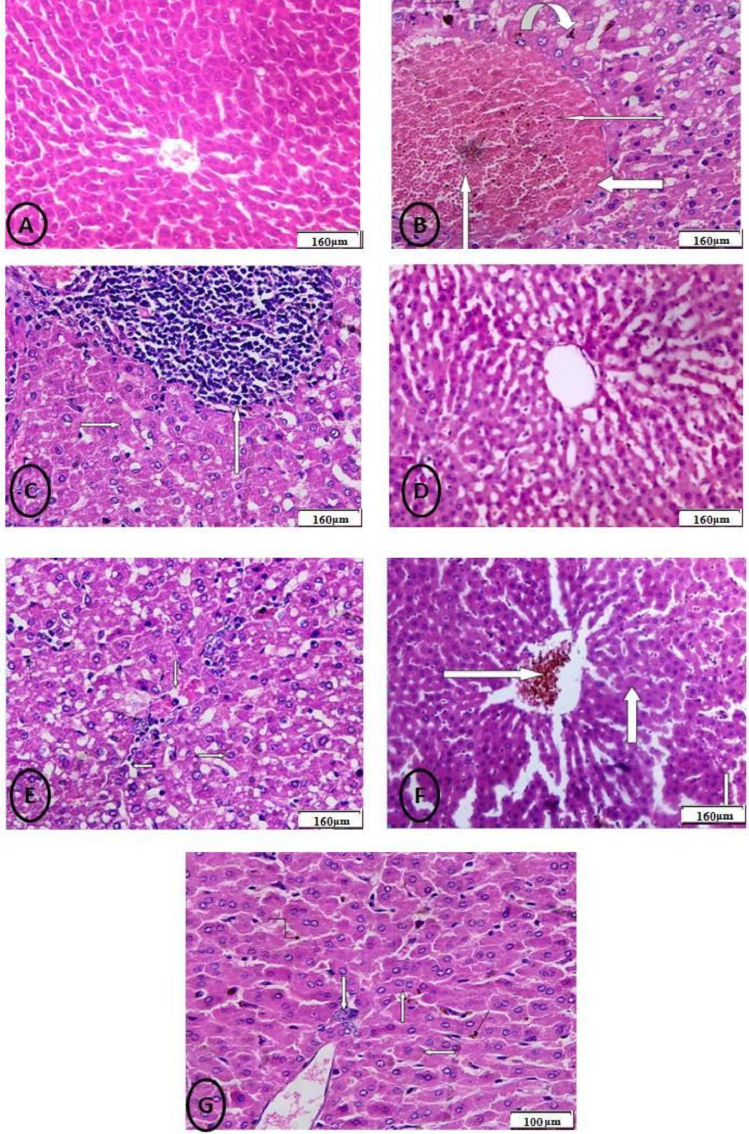
Figure 10. ( A ) Control group: photomicrograph of the cross-section of the hepatic tissues